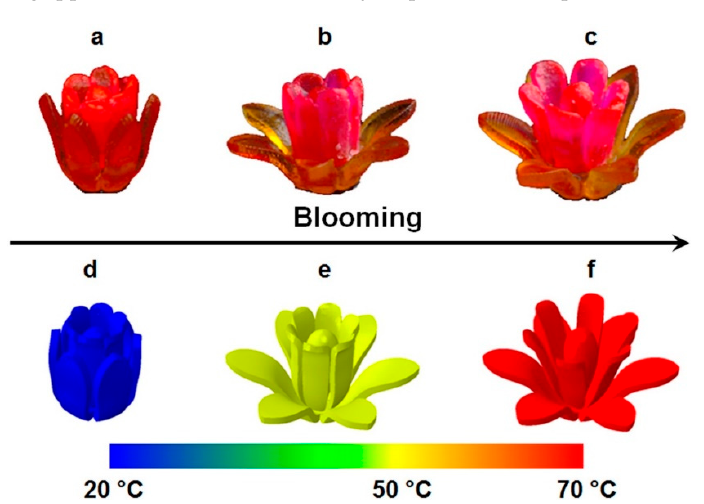
Figure 41. 3D printed multi-material grippers: ( a ) different sizes and designs of 3D printed grippers; ( b ) illustration of transitions between printed and temporary shapes as a function of temperature; ( c ) gripper used to lift a bolt assembly. Reproduced with permission from [61].